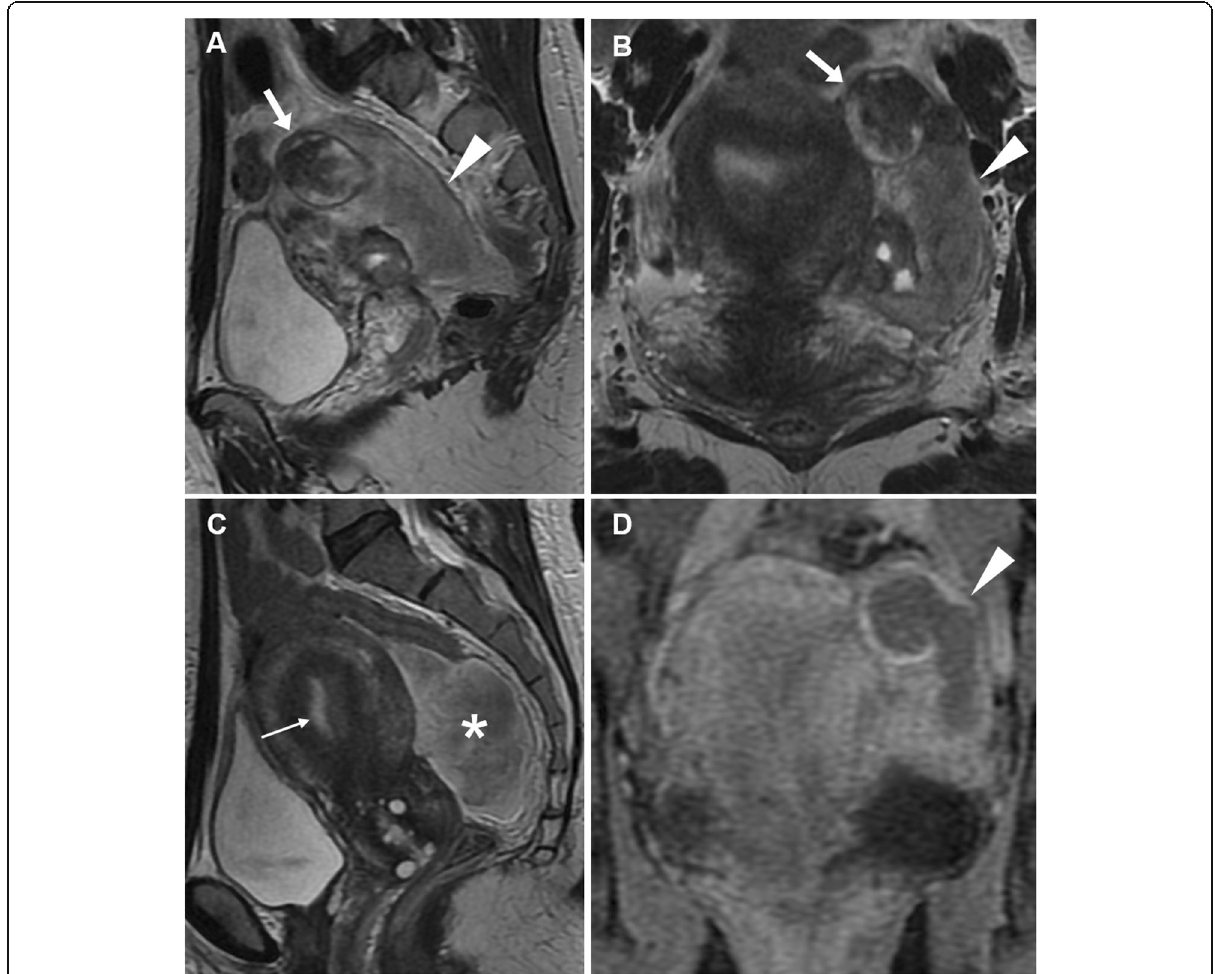
Fig. 17 MRI of a ruptured first-trimester ectopic pregnancy in a 44-year-old woman with acute abdominal pain and elevated β -hCG levels. Sagittal ( a ) and oblique-coronal ( b ) T2-weighted images show a tubular left adnexal mass (arrowheads) containing a gestational sac in the isthmus of the fallopian tube (arrows). On oblique-coronal fat-suppressed T1-weighted image ( d ), the distended fallopian tube displays a thick hyperintense wall (arrow) consistent with haematosalpinx. Additionally, sagittal T2-weighted image ( c ) demonstrates a predominantly low-signal haemorrhagic fluid collection (asterisk) in the pouch of Douglas. Note the empty endometrial cavity (thin